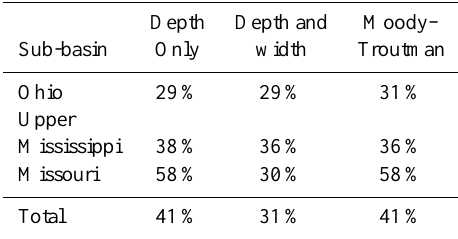
Table 4. Mean absolute depth errors (%).